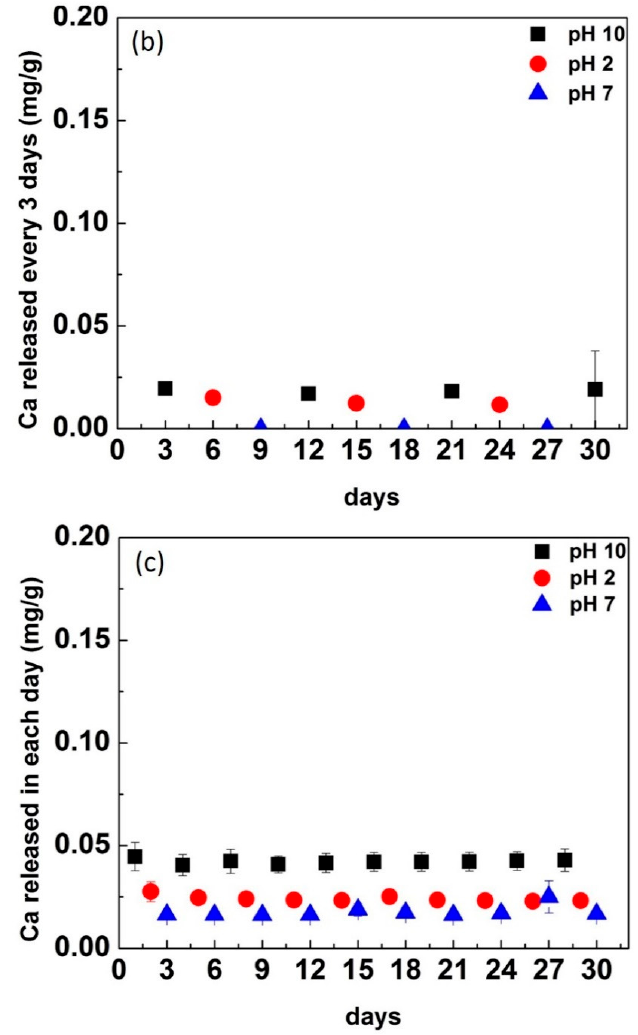
Figure 4. The cumulative Ca 2+ ion released in each condition ( a ) and the Ca 2+ released in each pH and time individually in ( b ) 3-d cycling and ( c ) 1-d cycling.